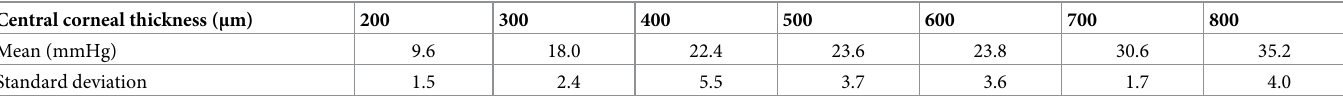
Table 2. Intraocular pressure of the 3D-printed model eyeballs for each central corneal